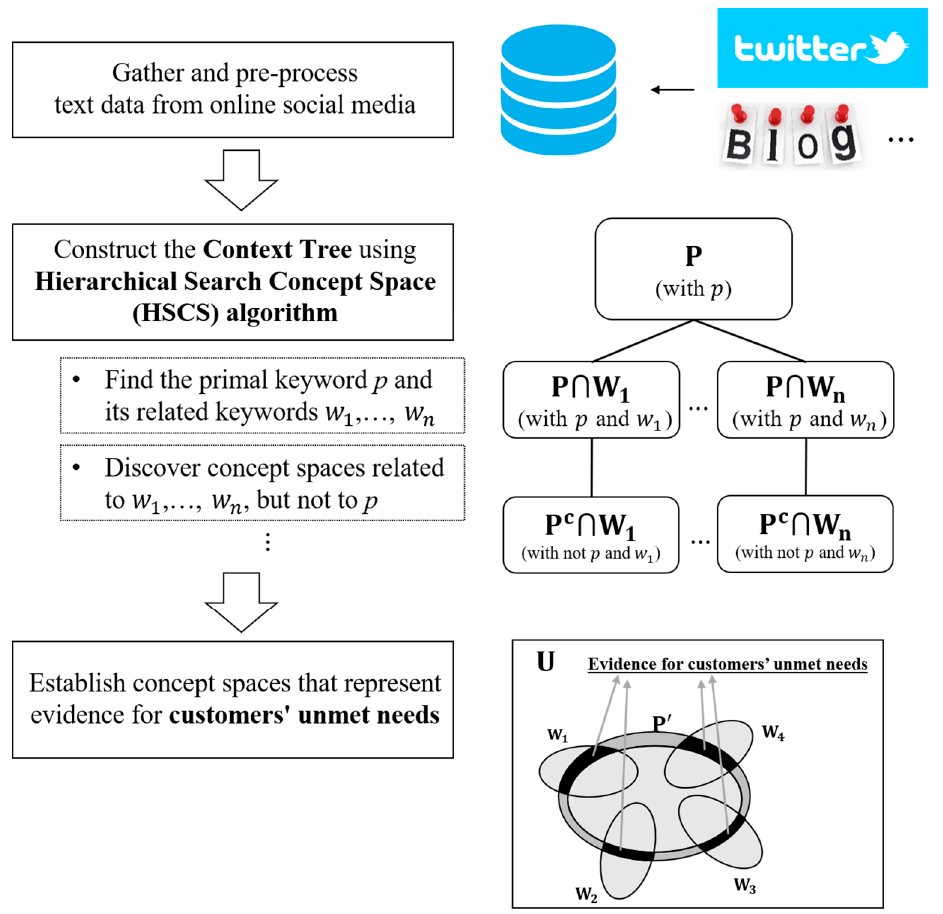
Figure 1. Proposed pipeline for identifying customers’ unmet needs using the Context Tree.